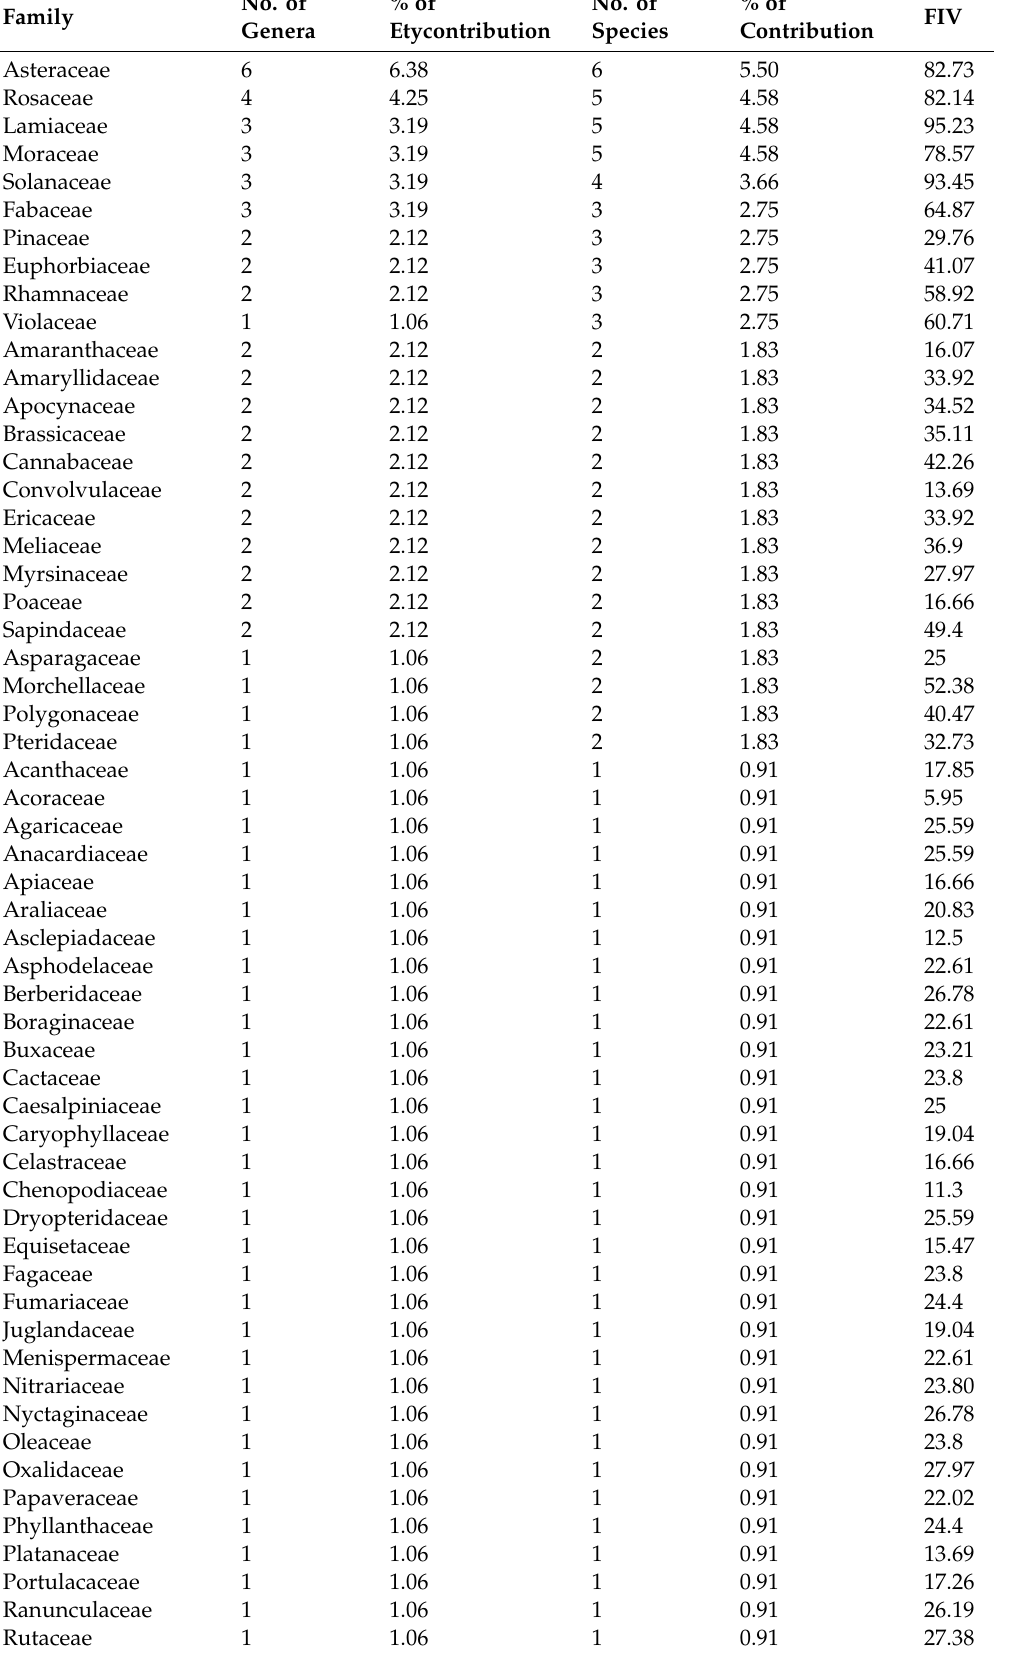
Table 5. Family wise distribution of medicinal plants and fungi in the study